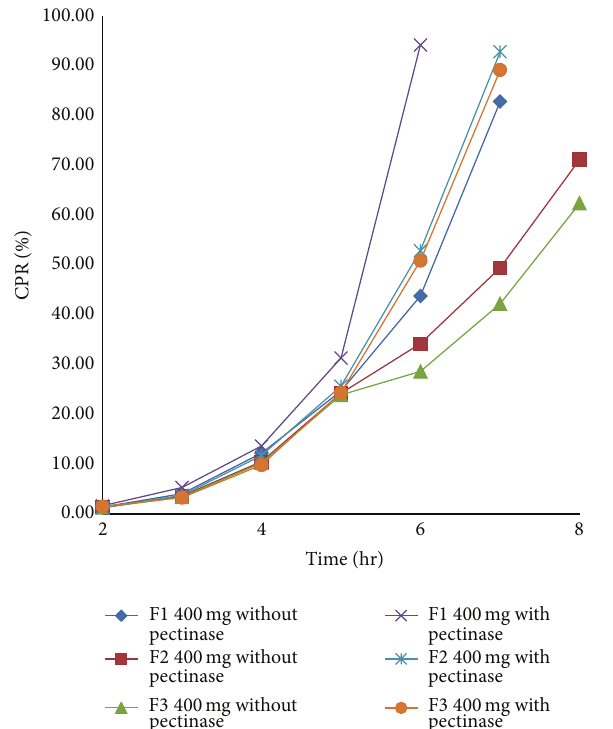
Figure 1: In vitro dissolution profile of batch F1 to F3 with and without pectinase enzyme.